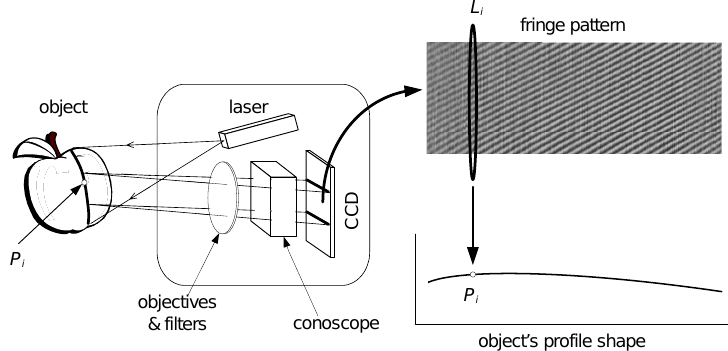
Figure 6. Linear sensor including triangulation (courtesy of